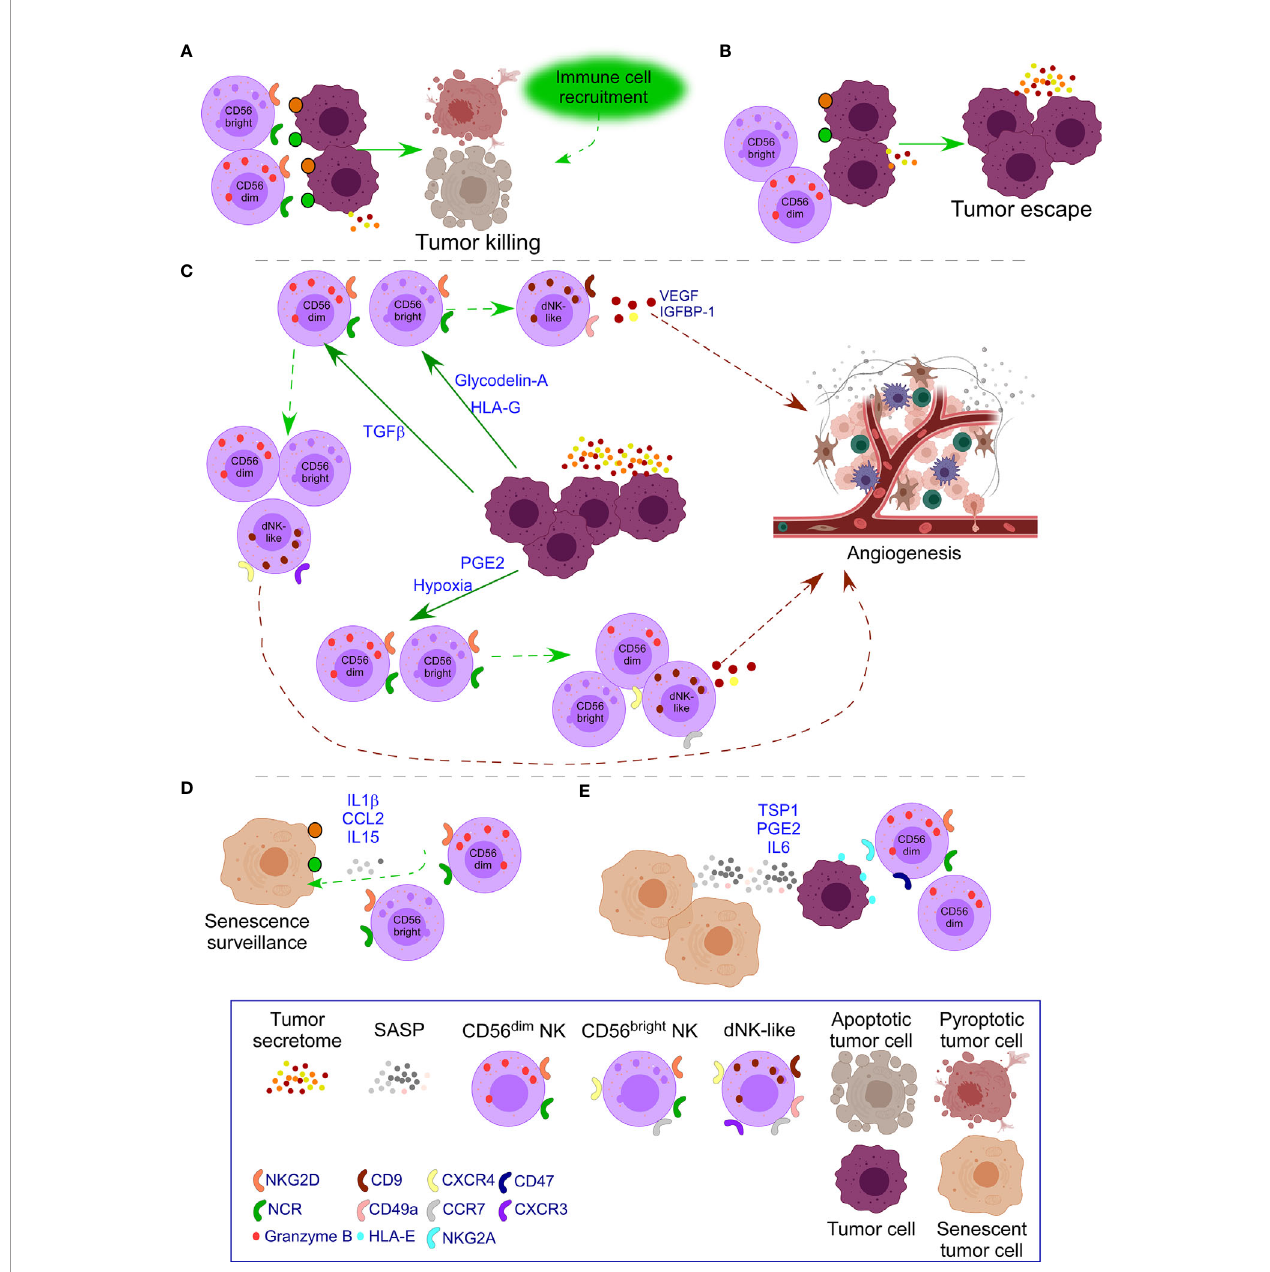
FIGURE 3 | Impact of tumor secretome in NK cell activity. (A) In healthy conditions, NK cells recognize transformed cells through ligands of NKG2D and the family of NCR receptors (NKp30, NKp44, NKp46) which are over-expressed in transformed cells. Pro-in fl ammatory forms of cell death attract additional immune cells to cooperate in the killing. (B) In some cases, tumor cells down-regulate ligands for NK cell receptors or the tumor microenvironment (TME) causes down-regulation of activating NK cell receptors leading to tumor escape with additional secretion of tumor secretome. (C) When tumor escape occurs, increased tumor secretome leads to additional changes in NK cells. Speci fi cally, release of Glycodelin-A and HLA-G converts immunoregulatory CD56 bright PB-NK cells into dNK-like cells. TGF b converts both cytotoxic CD56 dim and CD56 bright NK cells into dNK-like cells; and down-regulates NK cell activating receptors limiting NK killer activity. PGE2 and hypoxia inhibit the expression of NK cell activating receptors and their functional maturation leading to suppressed NK cell cytotoxicity. Moreover, hypoxia, preserves immature CD56 bright NK cells with expression of receptors of dNK cells, resembling to dNK-like cells. In all cases, dNK-like cells will activate angiogenesis processes. (D) Emergence of senescent tumor cells leads to SASP secretion that attracts NK cells to mediate their clearance. (E) When the number of senescent cells increases, the SASP also does, leading to inhibition of NK cell activity, through mechanisms, such as the interaction of HLA-E with the inhibitory receptor NKG2A in NK cells and binding of TSP1 with CD47 that inhibit NK cell activity. PGE2 and IL6 in the SASP also down-regulate NK cell activating receptors. Moreover, therapy- induced senescence in established tumors down-regulates NK cell activating receptors on mature NK cells and their ligands on tumor